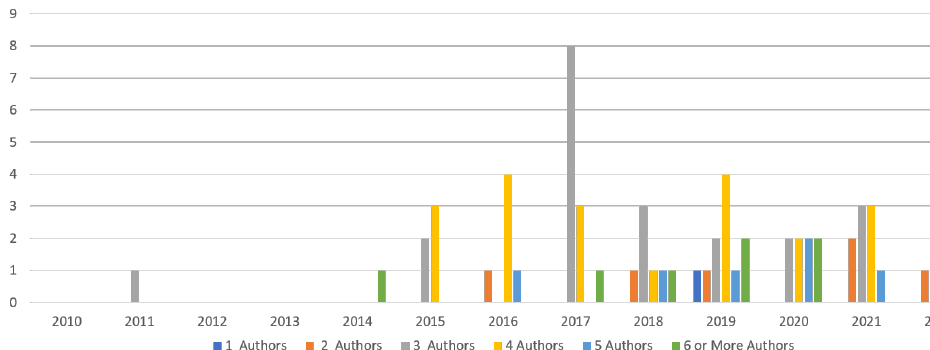
Figure 4. Distribution of papers by year and the number of